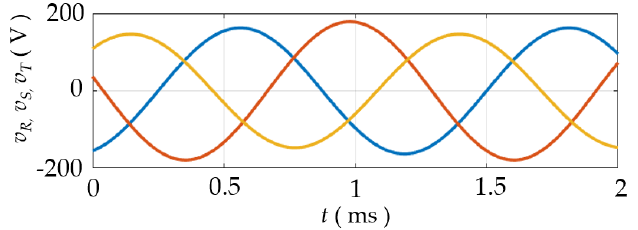
Figure 11. Typical input voltage waveforms under unbalanced operating conditions.